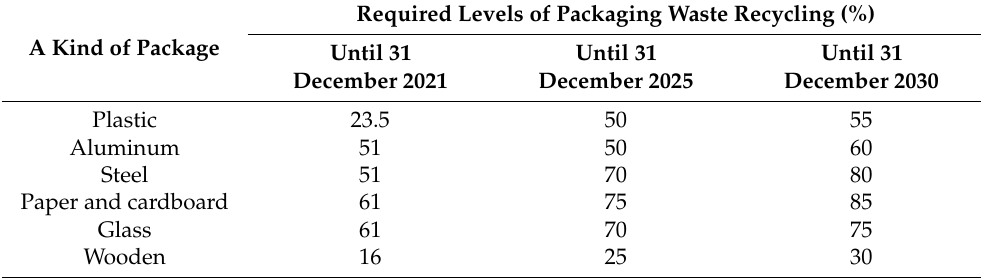
Table 2. Recycling levels of packaging waste in the example of Poland. Required Levels of Packaging Waste Recycling A Kind of Package